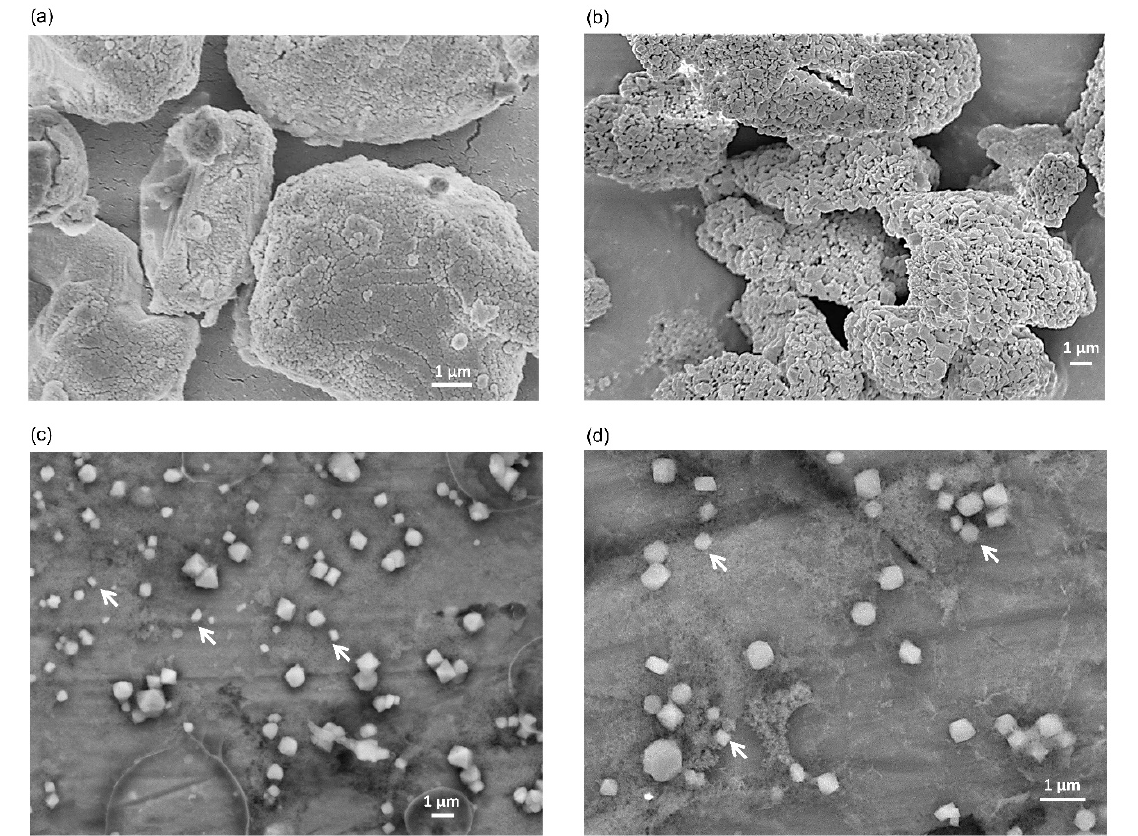
Figure 3. SEM images of BiSCaO ‐ 6 dry powder and dispersion. The surface structure of each dry powder of BiSCaO ‐ 6 immediately after opening at 10,000 ‐ fold magnification ( a ) and BiSCaO ‐ 6 placed under high humidity at 37 °C for seven days at 5000 ‐ fold magnification ( b ) were observed with SEM images of a field ‐ resolved scanning electron microscope. Cryo ‐ SEM observations were performed on BiSCaO ‐ 6 dispersions (0.2 wt% BiSCaO ‐ 6, 0.12 wt% Na 2 HPO 4 ) two days after adjustment at 5000 ‐ fold magnification ( c ) and 10,000 ‐ fold magnification ( d ). Allows indicate nano particles.